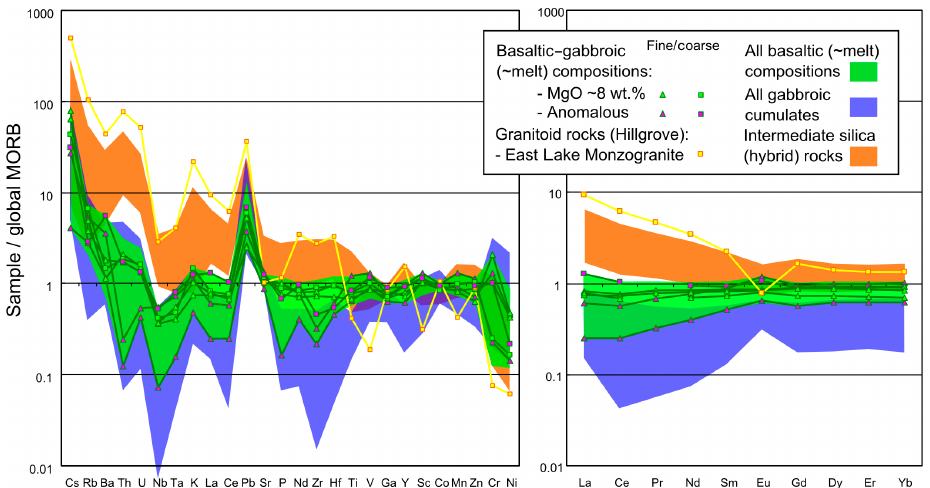
Figure 5. Trace element chemistry of bulk samples, normalised to global MORB (Arevalo and McDonough, 2010). Finely and coarsely crystalline gabbros (triangles and squares respectively) that approximate melt compositions with ∼ 8wt% MgO are in green; anomalous melt compositions in pink; East Lake Monzogranite (Hillgrove Suite) in yellow. Range of compositions for basaltic melts, cumulates, and higher silica (basaltic andesite or andesitic) hybrid melts are given by green, blue, and orange fields respectively.